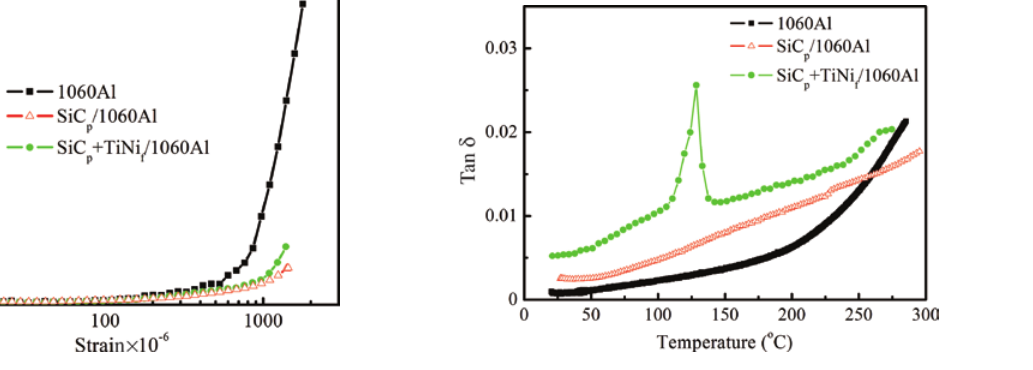
Figure 7 Damping capacity vs. strain curves of the Al matrix, SiC Al, and SiC +TiNi /Al composites. p f